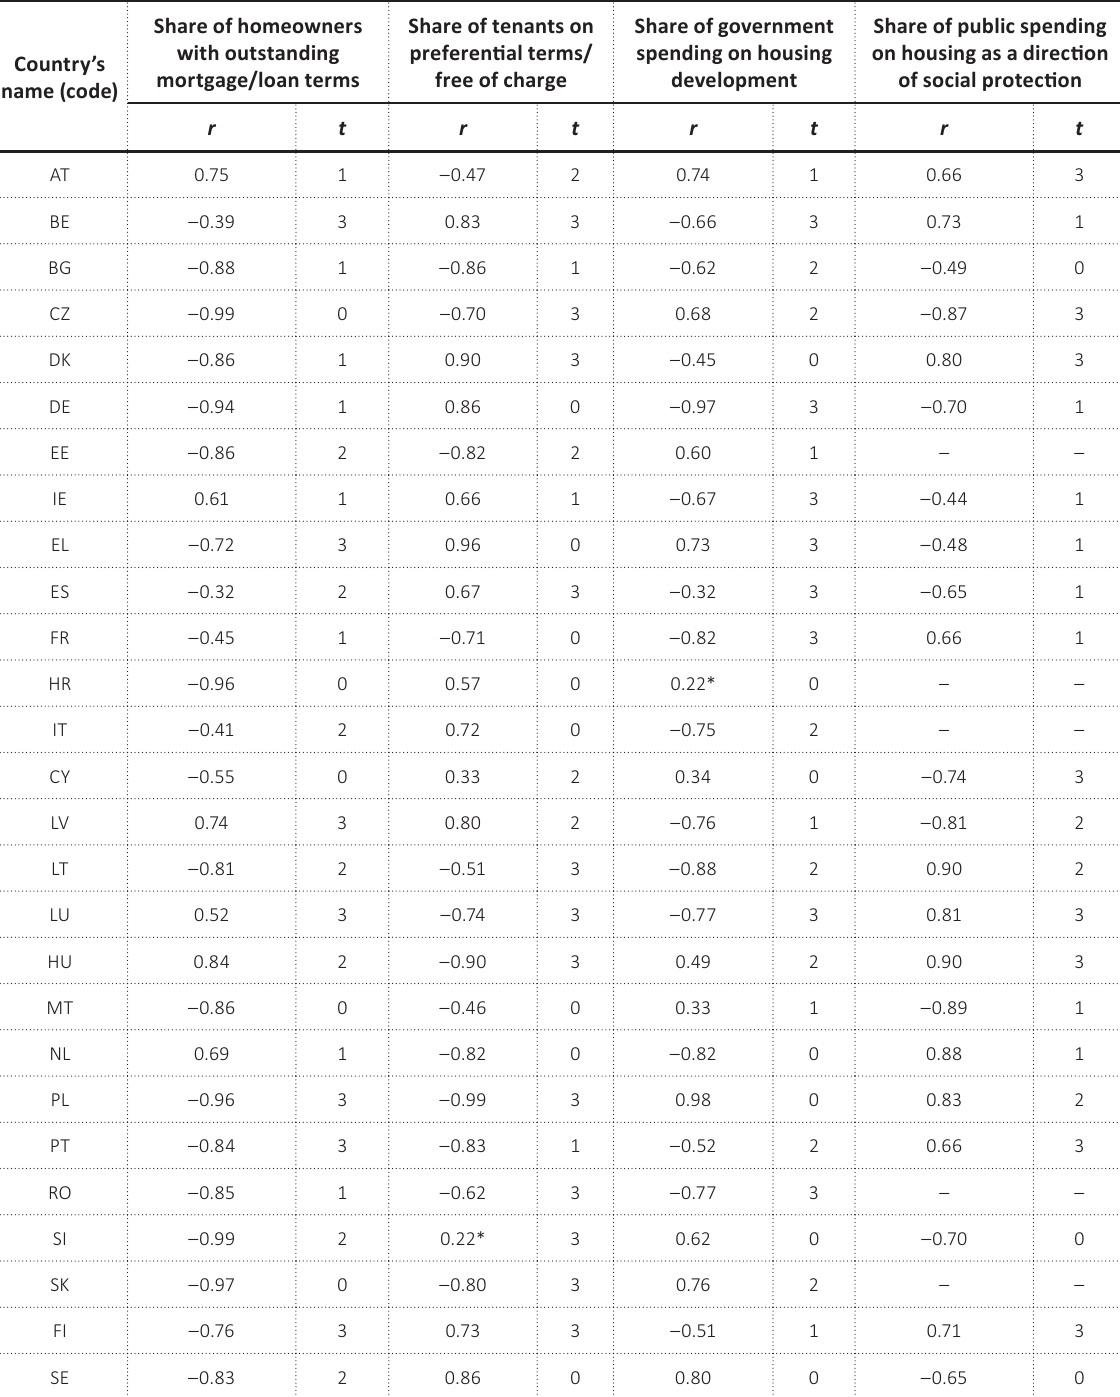
Table A2. Statistical significance, nature, and strength of the impact of changes in social housing financing on changes in the level of overcrowding (sample from 27 EU countries for 2011–2019) Source: Calculated by the authors in the STATA software